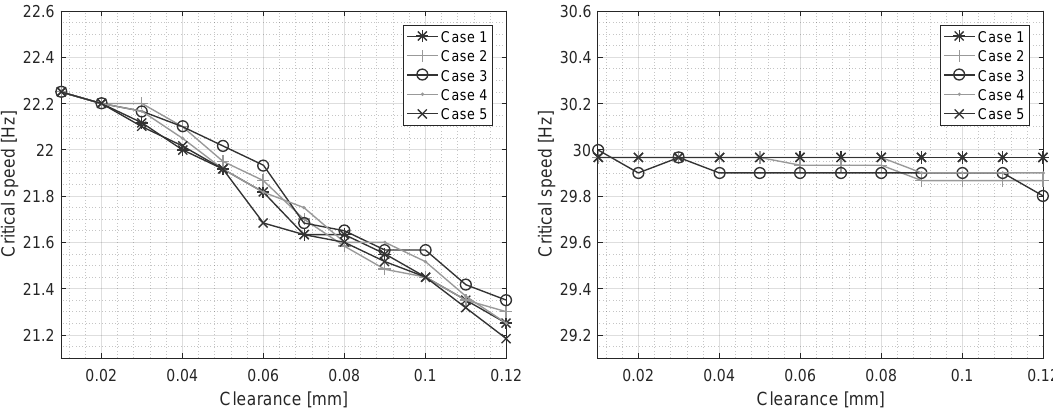
Figure 16. Critical speeds for cases 1 to 5 in horizontal direction (left) and vertical direction